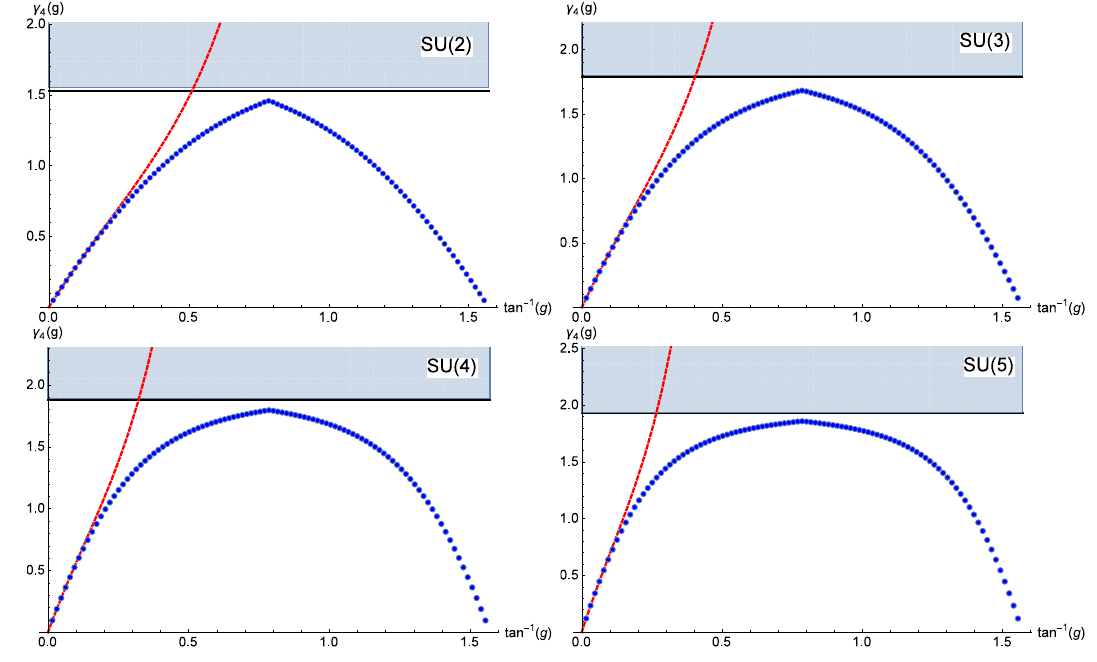
Figure 9 . Similar plots for the spin-4 operator as (cid:12)gure 3 and 6. The interpolating function ( (cid:28) ) for (cid:18) = 0 is plotted as the function of g . The red dashed line denotes the weak coupling F (30 ; 1 = 3) 3 expansion up to 3-loop.